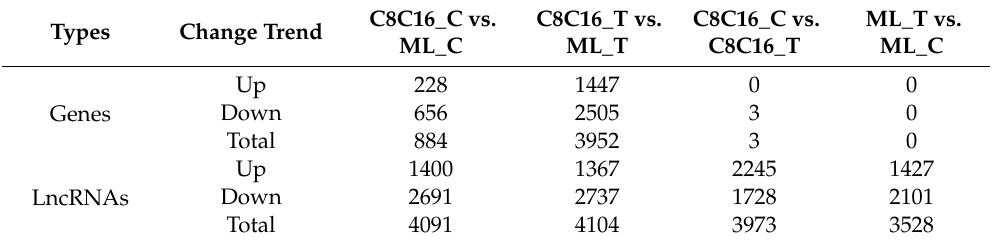
Table 1. Quantification of di ff erentially expressed genes and lncRNAs in bovine embryos at 8-16-cell and morula treatment included CUFF.17837.1, CUFF.21976.3, CUFF.30537.1, CUFF.50309.1, and CUFF.87588.1.